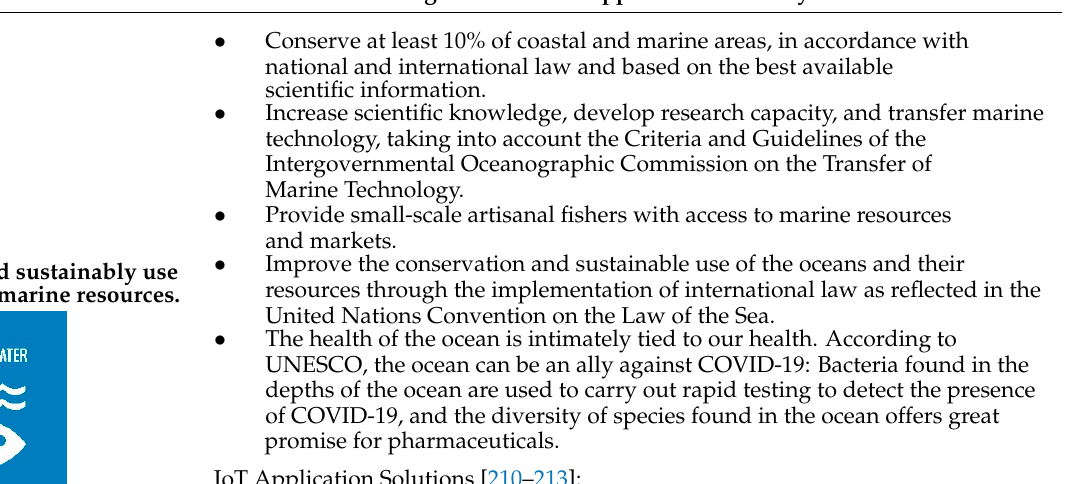
Table 5. Cont. Table 5. Impact of the Sustainable Development Goals on IoT applications for improving health and the environment. SDGs Targets Goals and Application to IoT Systems SDGs Targets Goals and Application to IoT Systems